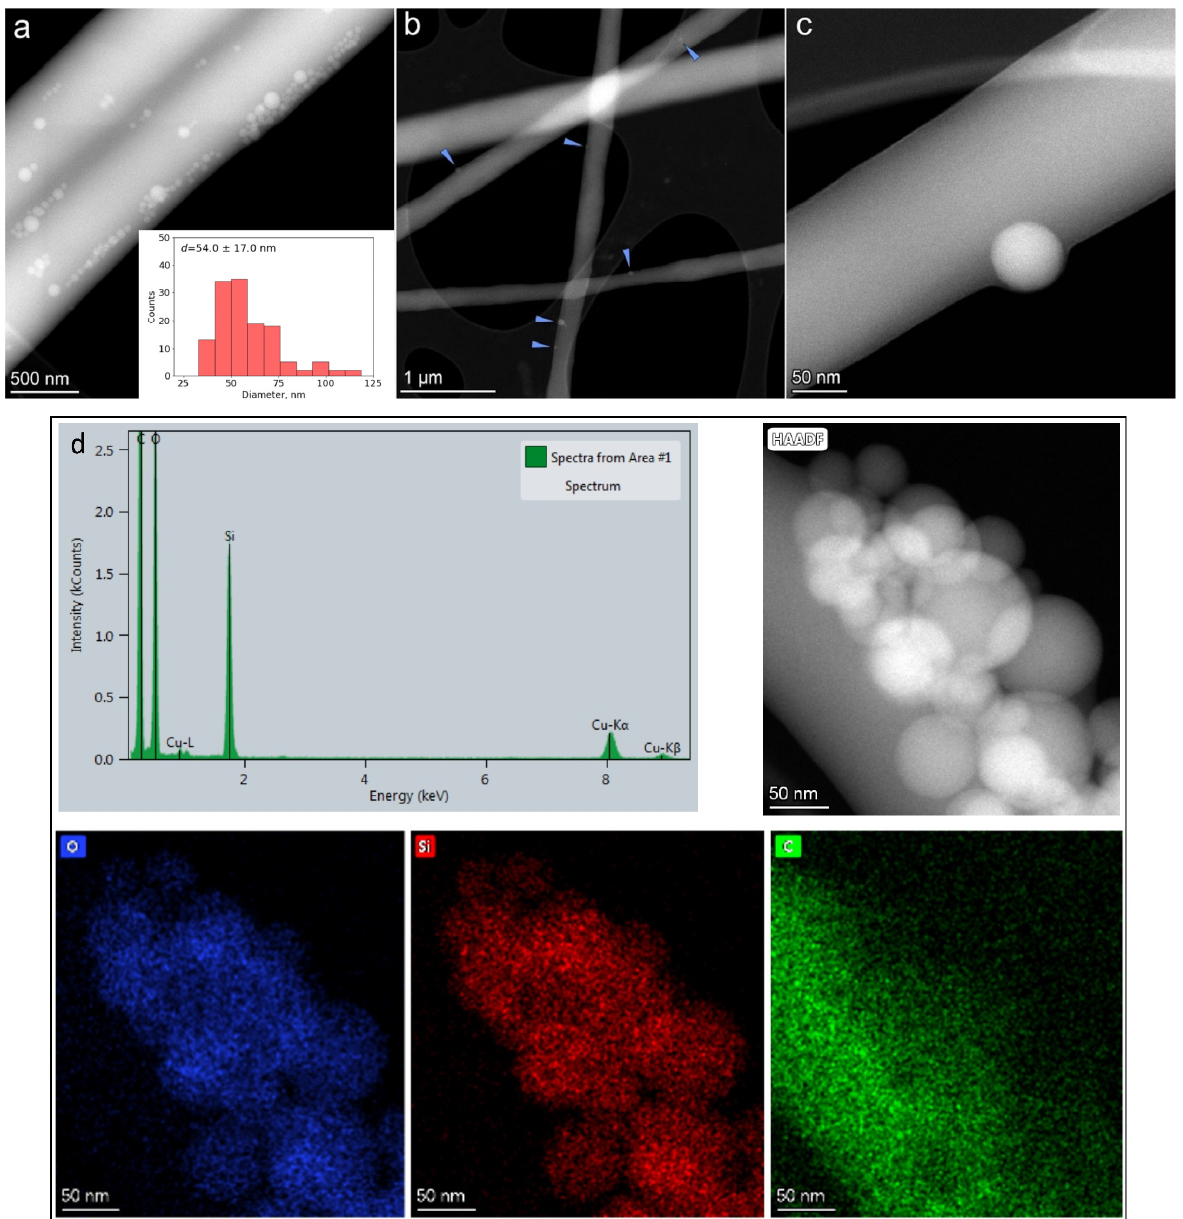
90:10 (Figure 5a). The average particle size distribution of silica was calculated from STEM images, where the size distribution ranges from 20 to 120 nm, and mean diameter of silica d equals to 54 ± 17 nm. EDX compositional maps were registered for O, Si, and C elements to detect the distribution of silica spheres in the core fiber PVA–PEG–SiO 2 (90:10) in Figure 5d.